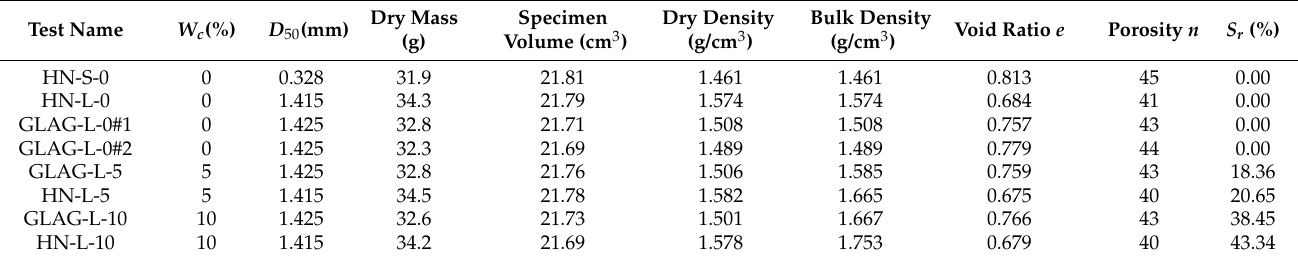
Table 2. Properties of quasi-oedometric